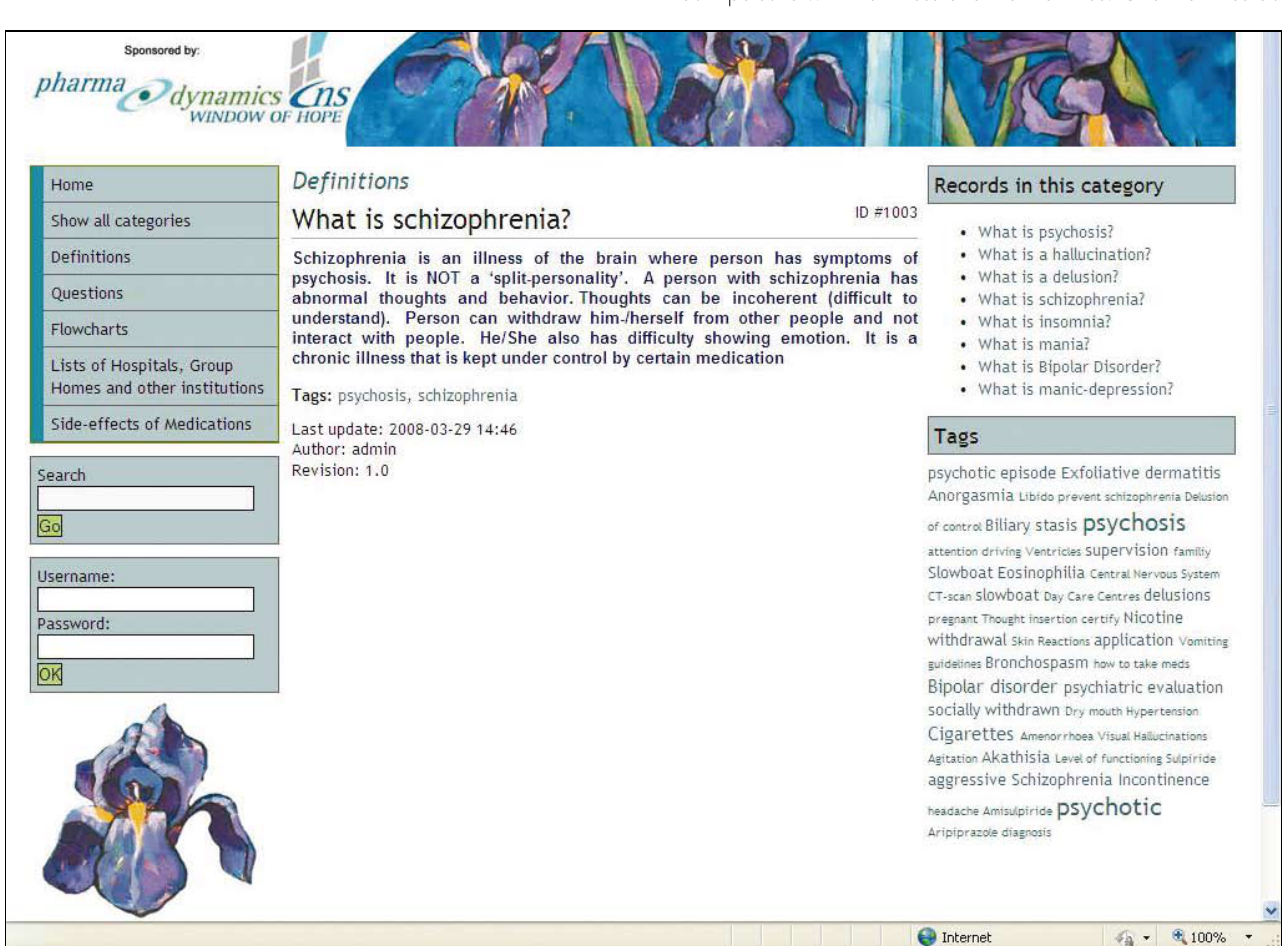
Fig. 2. Example of a flow diagram, schizophrenia-window-of-hope.com.